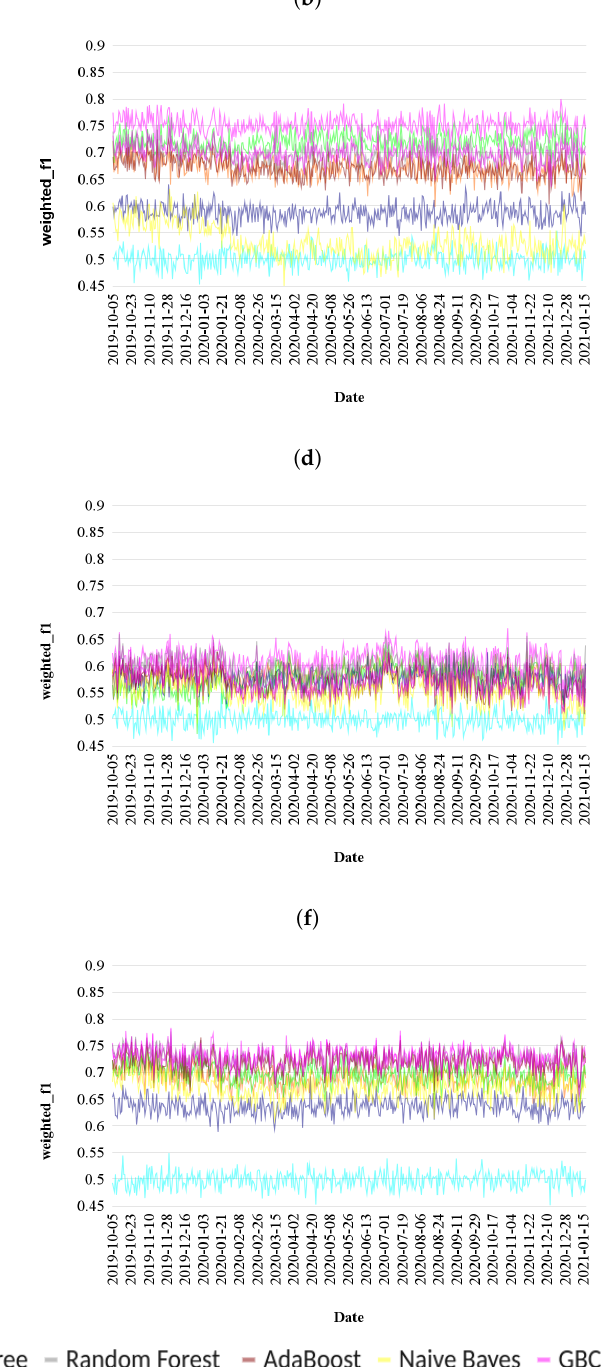
Figure A4. Performance evaluation (using weighted-f1) of the different models for each feature set in the 60-day training data. ( a ) Bag of Words; ( b ) Google Word2Vec; ( c ) Fake Word2Vec; ( d ) Lexical Categories (Empath); ( e ) Context-free features; ( f ) Best 15